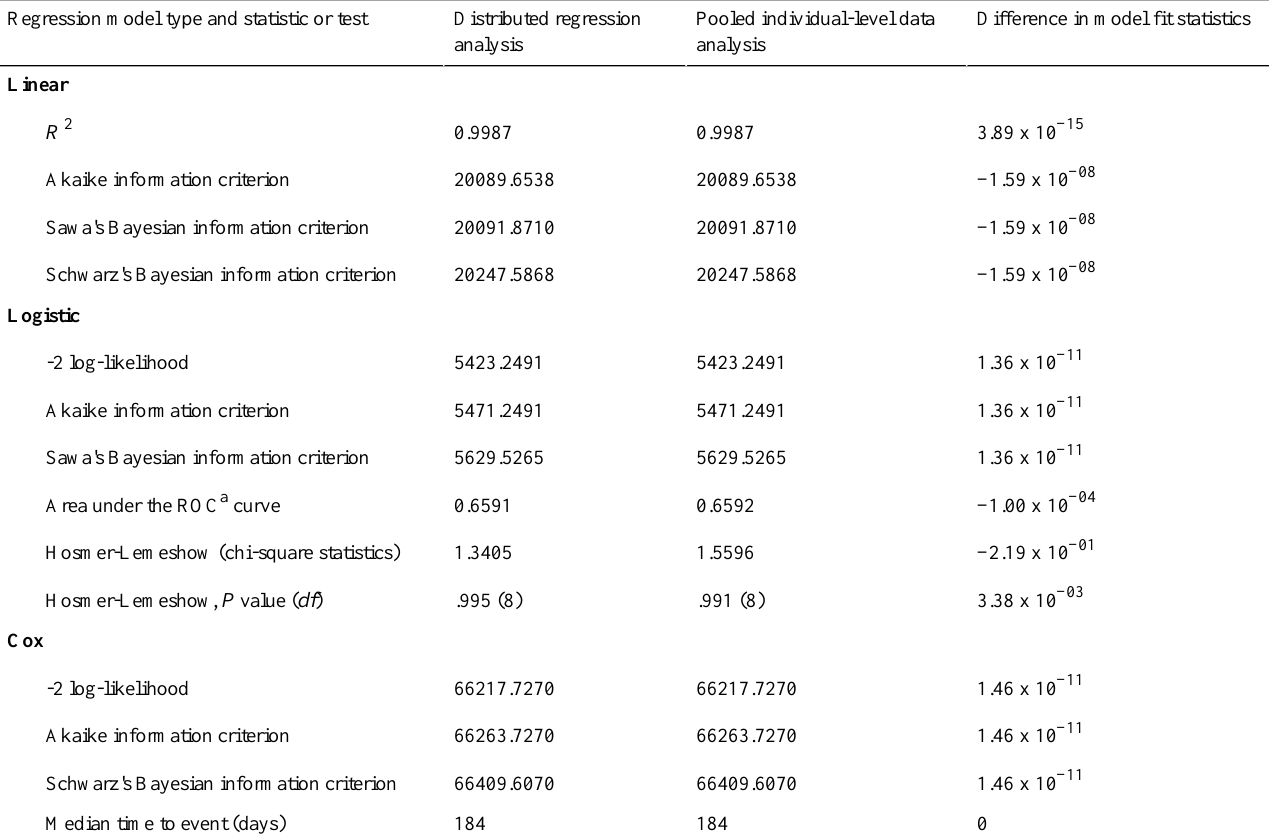
Table 5. Comparison of model fit statistics between distributed regression and pooled individual-level data analysis.